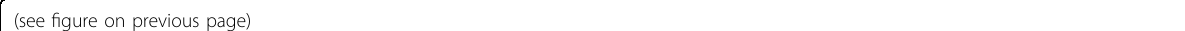
Fig. 5 Tet1 regulation via Rad50. a Quantitative real-time PCR analysis of Tet1 and Rad50 after Tet1 knockdown in mESCs overexpressing Rad50 or treated with an EV (empty vector). Data are expressed as the mean ± SEM. * p < 0.05, ANOVA with Tukey ’ s post hoc test. b Western blot analysis of Tet1 and Oct4 after Tet1 knockdown in mESCs overexpressing Rad50. The bottom panel shows quanti fi cation of western blot results. Data are expressed as the mean ± SEM, n = 3. ** p < 0.01, two-sided Student ’ s t test. c Dot blot analysis of 5mC and 5hmC in diluted genomic DNA from Tet1 knockdown mESCs that overexpress Rad50. The left panel shows the quanti fi cation of dot blot results. Data are expressed as the mean ± SEM, n = 3. ** p < 0.01, two-sided Student ’ s t test. d The number of colonies was counted during OSKM reprogramming after Tet1 knockdown in fi broblasts with Rad50 overexpression or treated with an EV. e Immunohistochemistry for Nanog (Red), Oct4 (green), and DAPI (blue) after Tet1 knockdown in fi broblasts with Rad50 overexpression or treated with an under OSKM induction conditions. f Quantitative real-time PCR analysis of pluripotency- associated gene markers. Data are expressed as the mean ± SEM. ** p < 0.01, ANOVA with Tukey ’ s post hoc test. The images ( b , c , and e ) are representative of ≥ 3 similar